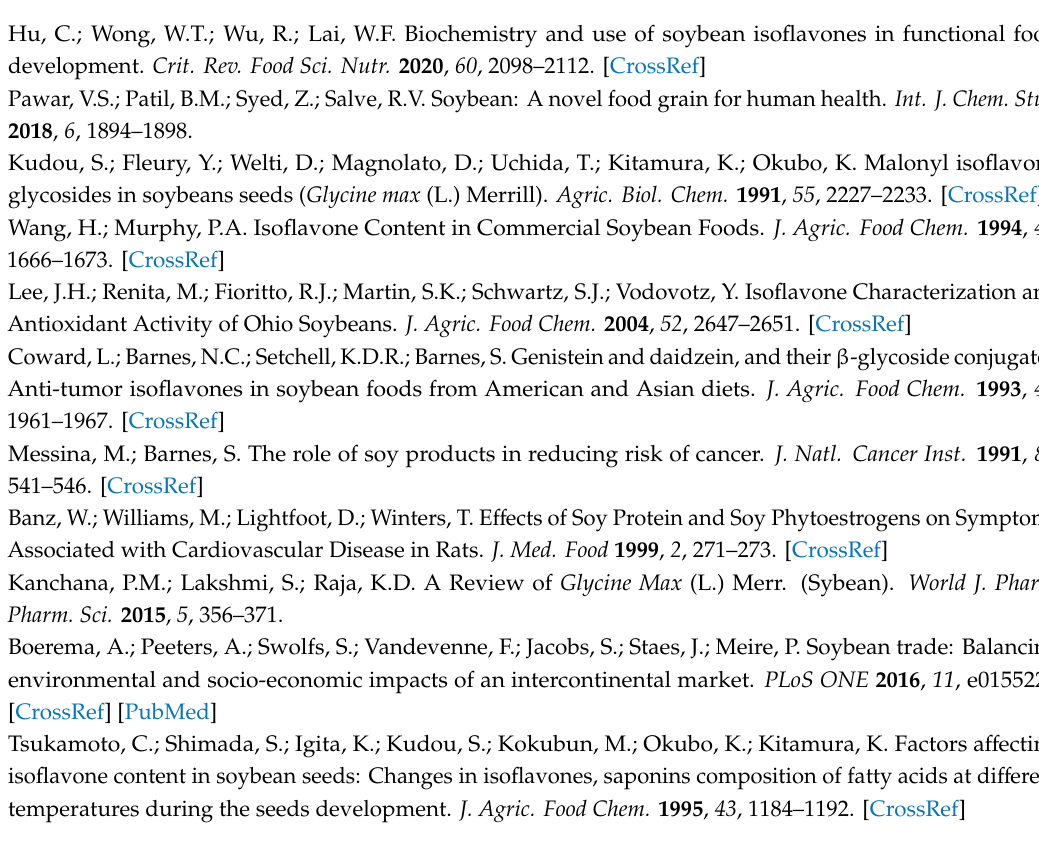
Figure A7. Loading plot of Principal Component Analysis carried out with the analyzed factors: temperatures and precipitation during the growing season (T03, T04, T05, T06, T07 and P03, P04, P05, P06, P07) and isoflavones concentration: daidzein (Dzein), genistin (Gstin), daidzin (Dzin); glycitin (Gly) and genistein (Gstein) based on the first and second components accounting for 55.40% and 44.59% of the total variability observed.